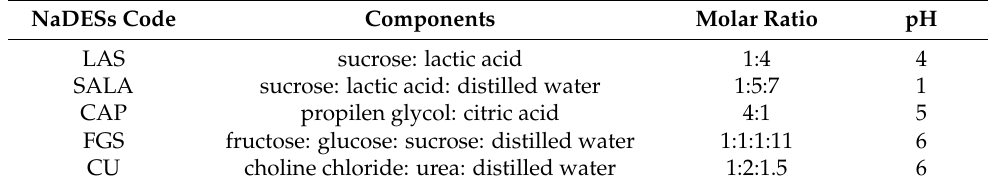
Table 2. Natural deep eutectic solvents (NaDESs) used for extraction.